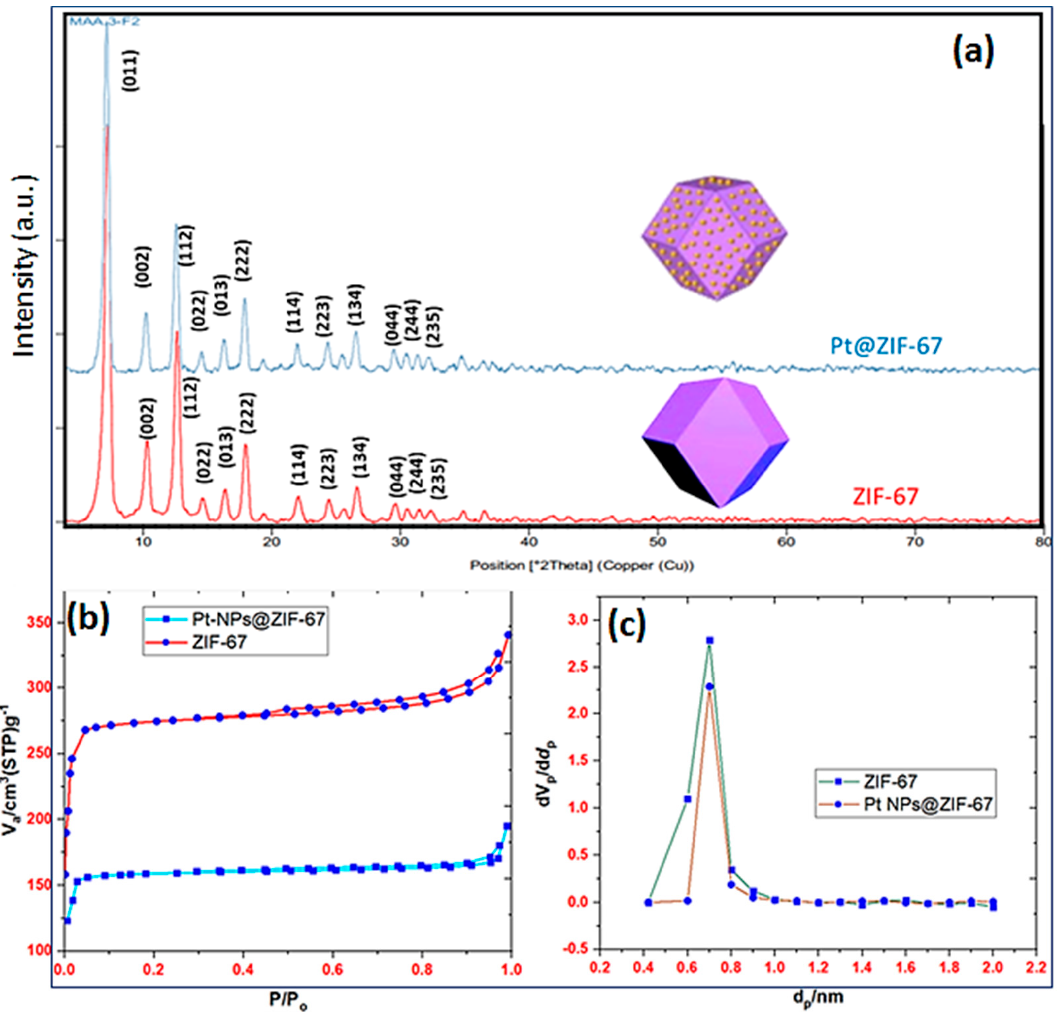
Figure 3. ( a ) ZIF-67 and Pt@ZIF-67: XRD pattern of (red) ZIF-67; (blue) Pt@ZIF-67. ( b ) The N 2 -adsorption-desorption isotherm of and ( c ) the pore size distribution of the ZIF-67 and the Pt@ZIF-67. Table 1. Specific surface area (SBET), diameter pore, and total pore volume. Sample